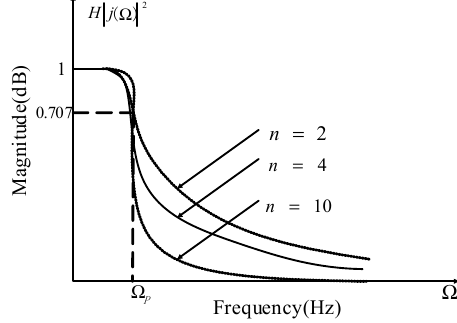
Figure 4. Relationship between the attenuation characteristics and the order of the filter.